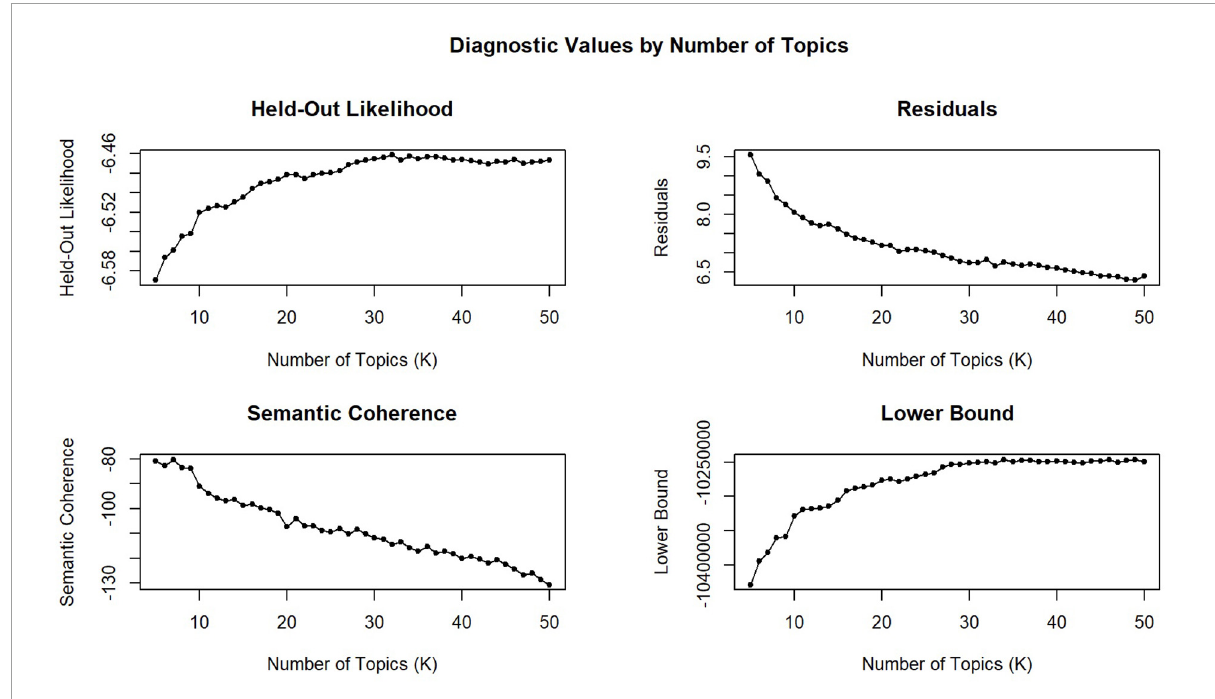
FIGURE2 Diagnostic values by number of